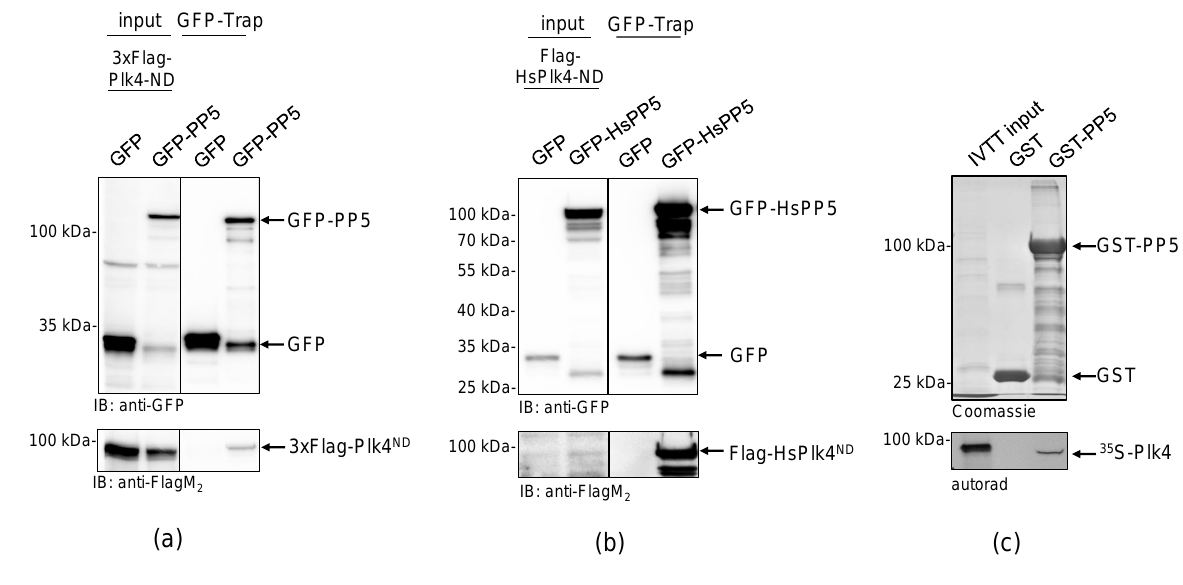
Figure 1. PP5 binds directly to Plk4 in Drosophila and human cells. ( a ) GFP-Trap affinity purification of GFP (negative control) or GFP-PP5 transiently co-expressed with Flag-Plk4-ND in D.Mel-2 cultured cells. Lysate inputs and purified proteins were subjected to SDS-PAGE and a western blot analysis, which shows that GFP-PP5 interacts with Flag-Plk4-ND. ( b ) GFP-Trap affinity purification of GFP (negative control) or GFP-HsPP5 (human PP5) transiently co-expressed with Flag-HsPlk4-ND in HEK293 cells. Western blot analysis shows that Flag-HsPlk4-ND specifically co-purifies with HsPP5 from human cells. ( c ) GST-IVTT in vitro binding assay: immobilized GST (negative control) or GST-PP5 recombinant proteins were incubated with 35 S-Plk4 and the interaction was analyzed by SDS-PAGE followed by autoradiography (autorad). Plk4 directly and specifically binds to GST-PP5, in